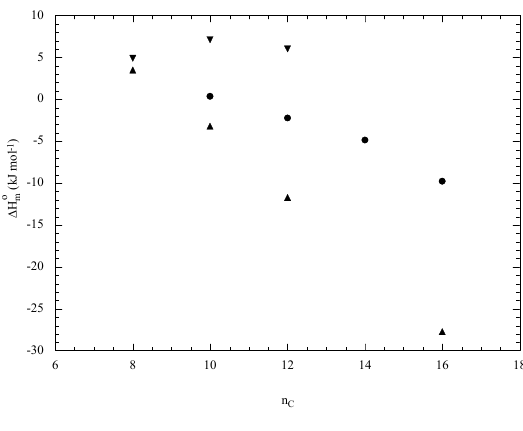
Figure 5. Enthalpy of micellization of alkyltrimethylammonium bromides ( ● , from Ref. [22]), alkylmethylpiperidinium chlorides ( ▼ , from Ref. [33]) and alkanediyl- α , ω - bis(alkyldimethylammonium bromides) ( ▲ , from Ref. [1] ) as a function of the number of carbon atoms in the surfactant alkyl chain at 298